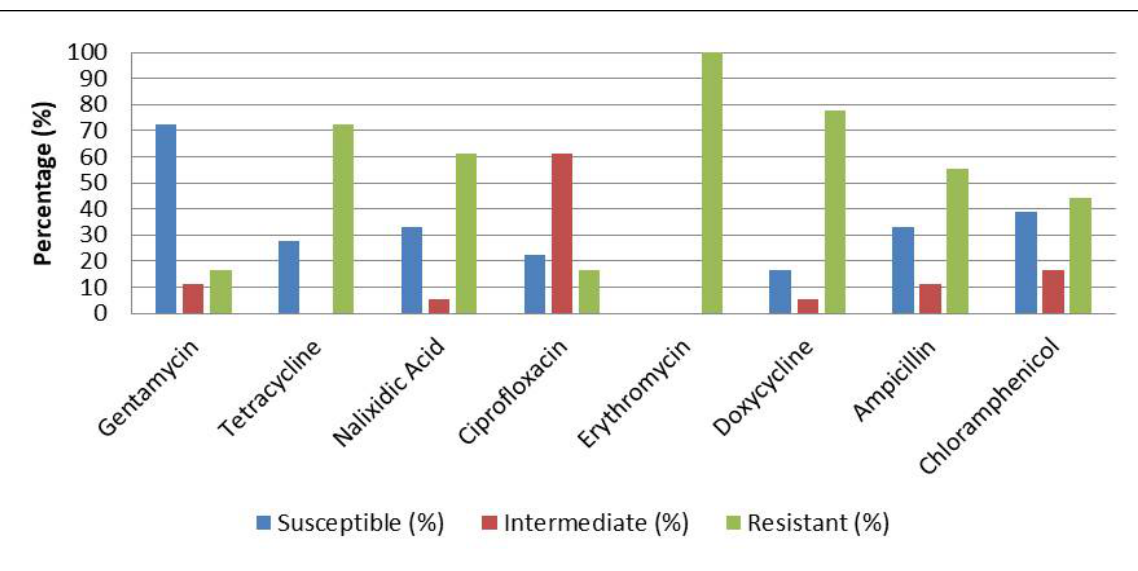
Figure 3: Percentage of resistant, intermediate and susceptible Salmonella spp. isolates from retail farmed shrimp to commercial